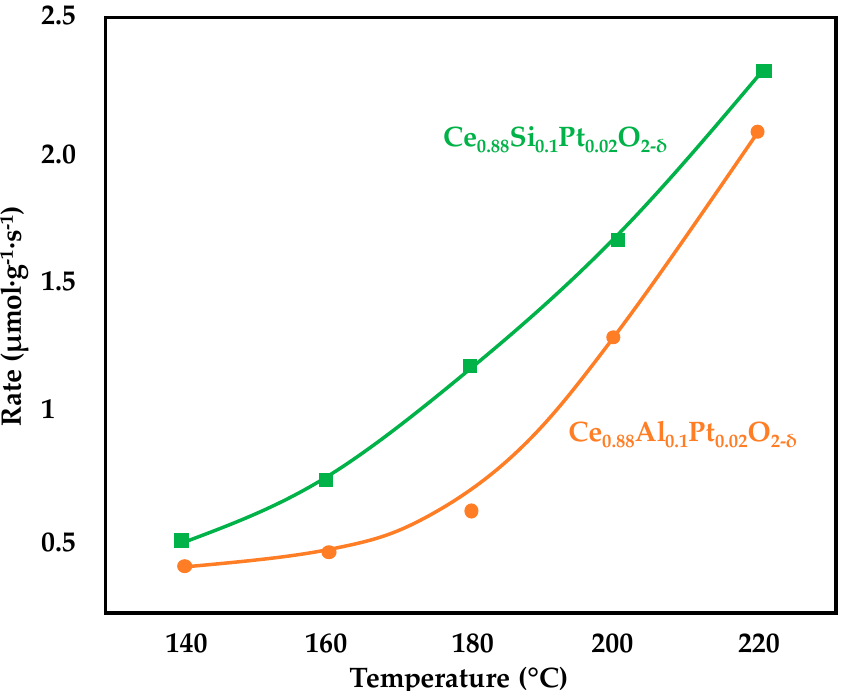
Figure 17. Variation of CO reaction rate with temperature over Ce 0.88 Si 0.1 Pt 0.02 O 2- δ and Ce 0.88 Al 0.1 Pt 0.02 O 2- δ catalysts adapted from [105], with permission from Wiley, 2012; P = 1 atm, 2% CO, 10% CO 2 , 10% H 2 , 55% H 2 O, 33% N 2 , GHSV = 48,000 h − 1.